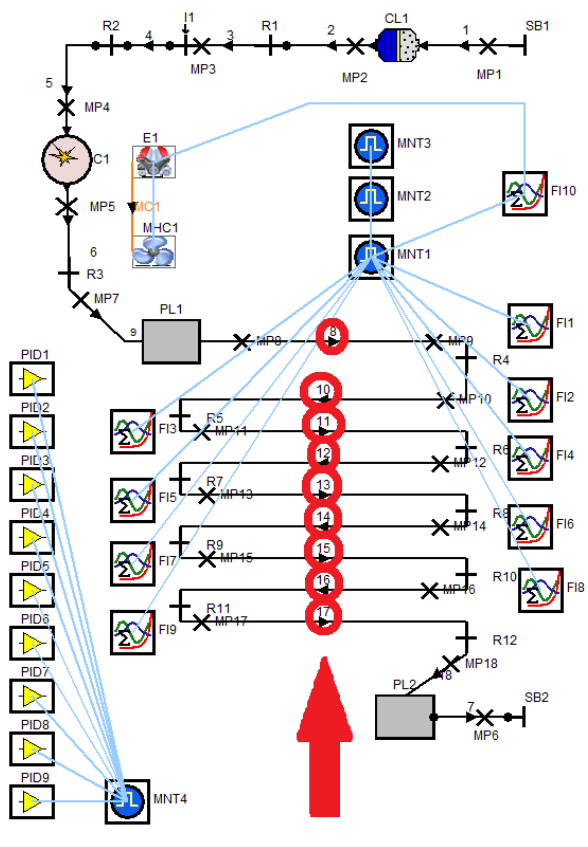
Fig. 4. Overall view of test bench in AVL Boost